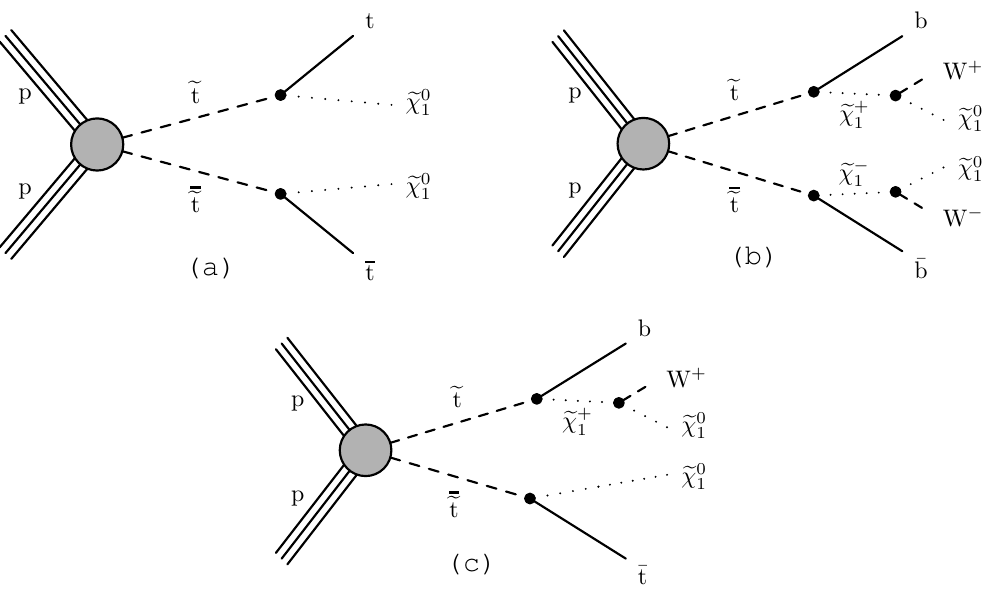
Figure 1 . Simpli(cid:12)ed-models diagrams corresponding to top squark pair production, followed by the speci(cid:12)c decay modes targeted in this paper. (a) pp